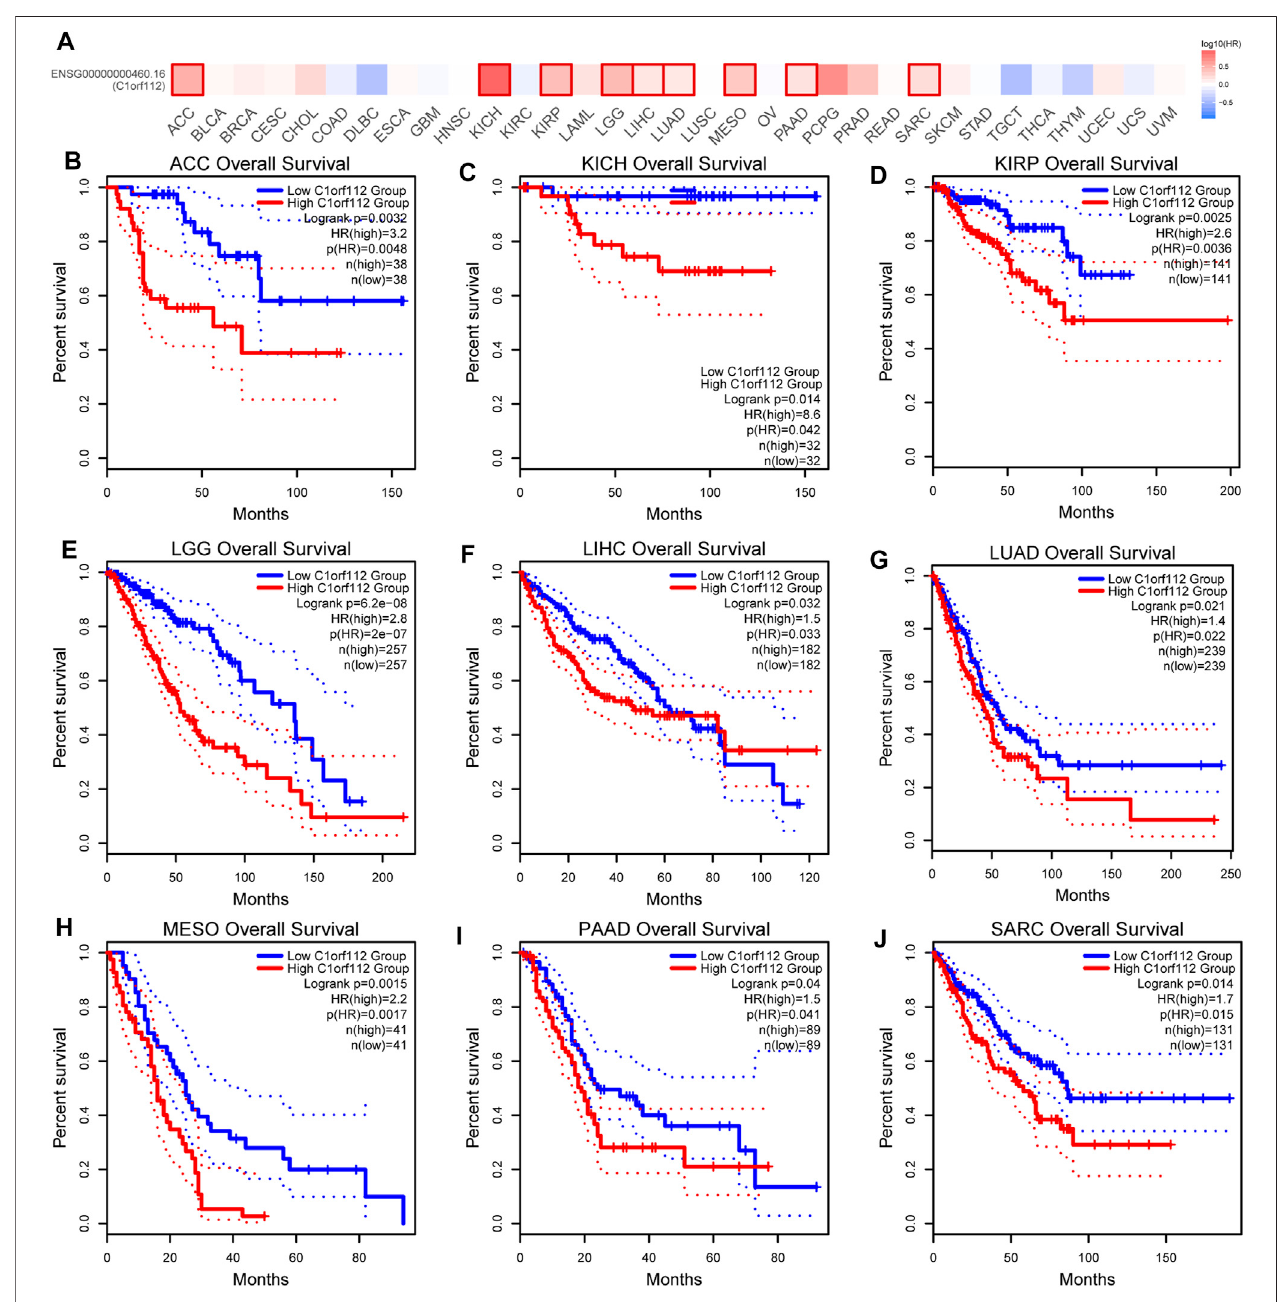
FIGURE 2 | Correlation between C1ORF112 expression and overall survival in patients with different TCGA tumor types. GEPIA2 was used to build a survival map (A) and conduct overall survival analyses (B – J) . The survival map and Kaplan – Meier plots with signi fi cant results are displayed. The 95% con fi dence intervals of overall survival are indicated by red and blue dotted lines for high and low C1ORF112 groups,